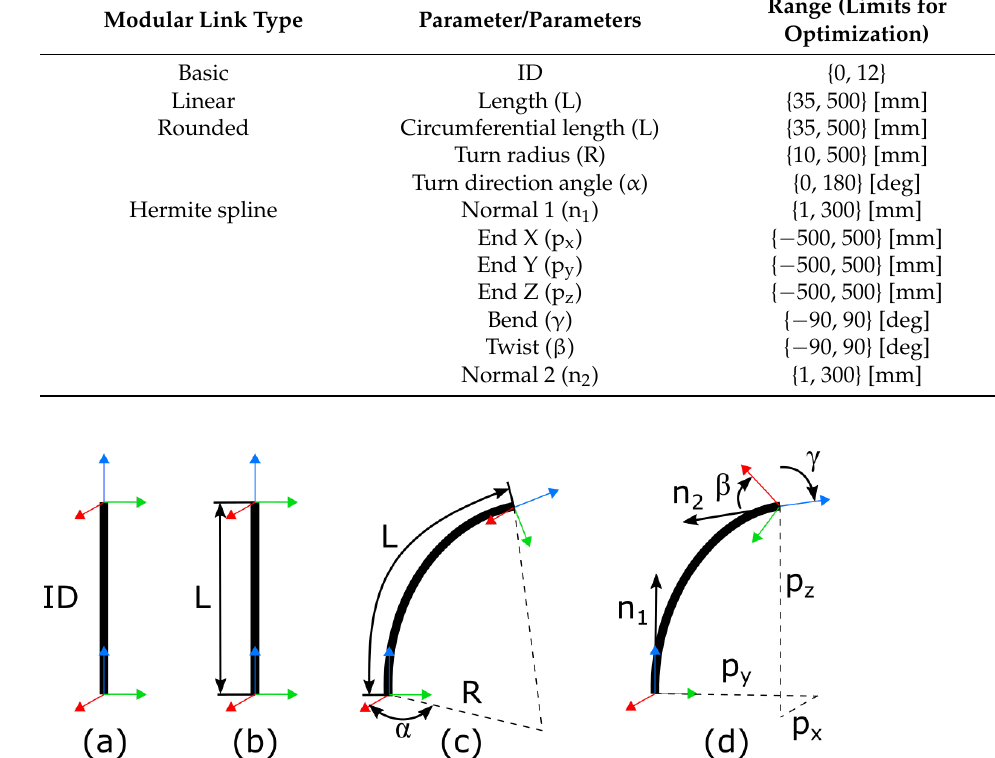
Figure 3. Types of links: ( a ) basic; ( b ) linear; ( c ) rounded; ( d ) Hermite spline.